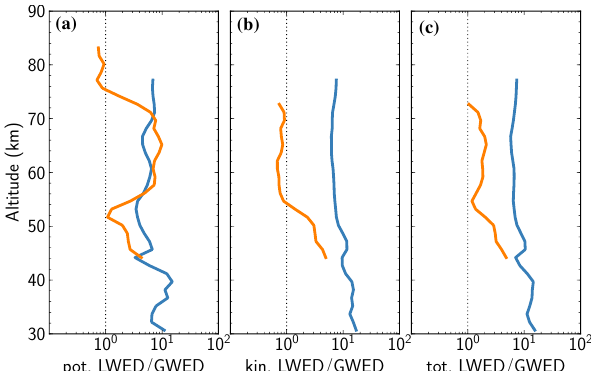
Figure 9. Mean LWED-to-GWED ratios for lidar data (orange) and ECMWF data (blue). Panel (a) potential energy densities. Panel (b) kinetic energy densities. Panel (c) total energy densities.